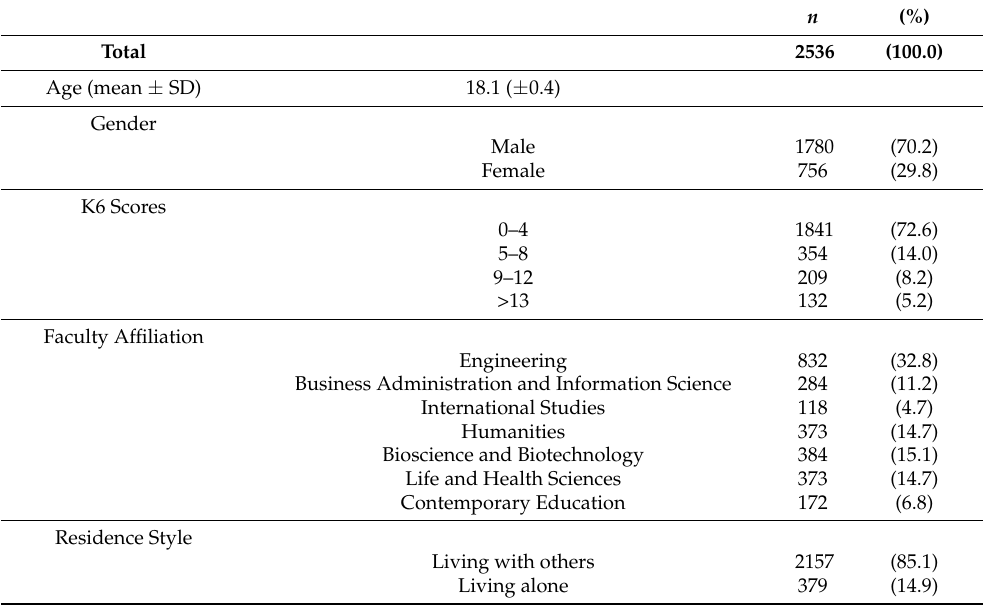
Table 1. The characteristics of study participants.